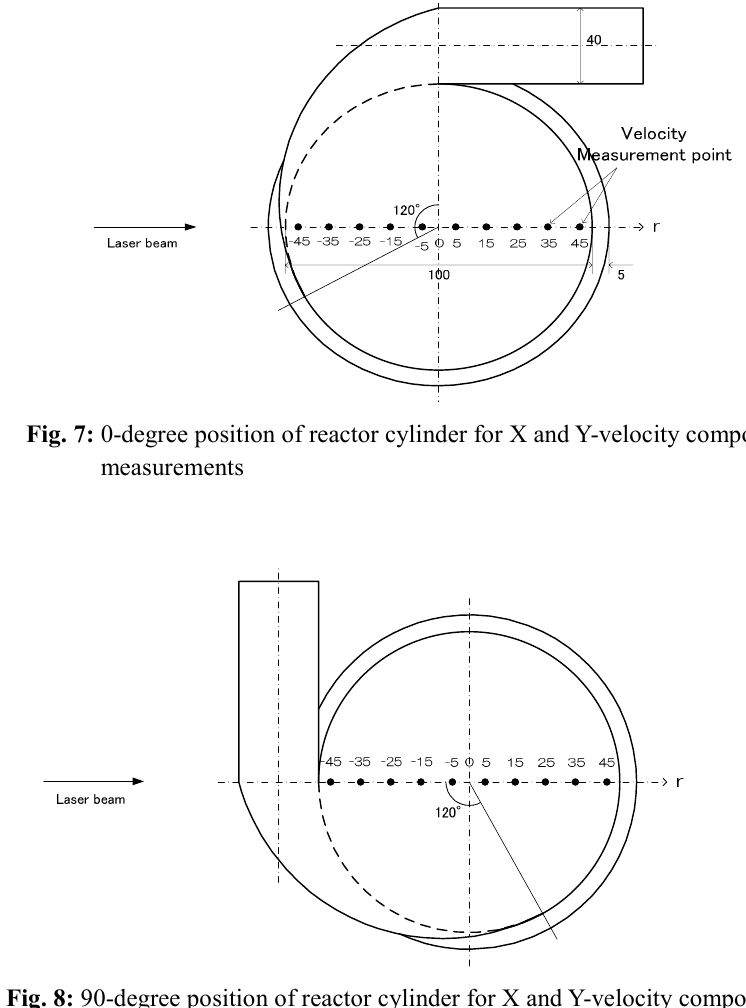
Fig. 8: 90-degree position of reactor cylinder for X and Y-velocity component measurements